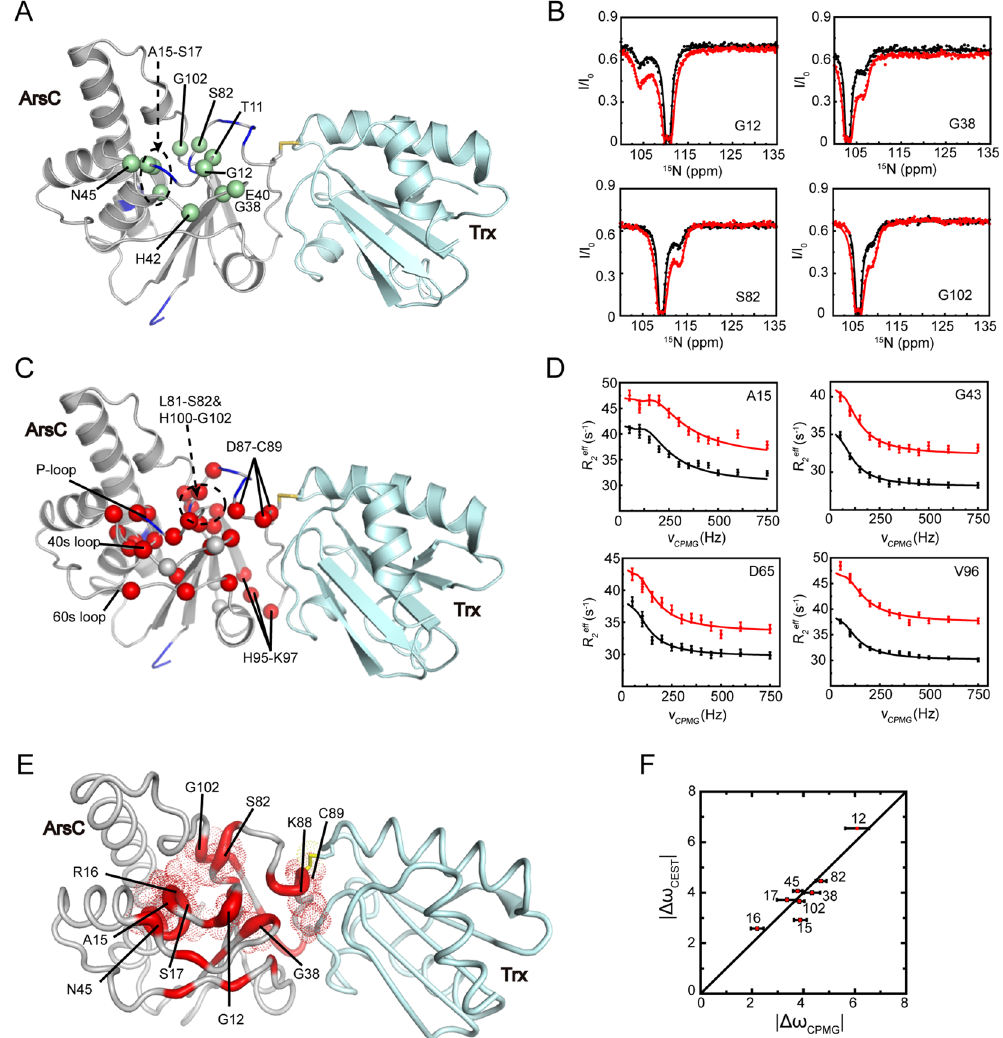
Figure 5. CEST and CPMG RD results of c-ArsC . ( A , C ) Residues showing conformational exchanges in c-ArsC identified by the CEST ( A ) and CPMG RD ( C ) experiments are mapped onto the Trx-ArsC complex structure (PDB ID: 2ipa), shown as green and red spheres, respectively. ( B ) Representative 15 N CEST profiles of c-ArsC obtained on a 600-MHz spectrometer using B 1 fields of 8.4 Hz (black) and 13.5 Hz (red). ( D ) Representative RD profiles of c-ArsC obtained on 600-MHz (black) and 800-MHz (red) spectrometers. ( E ) Mapping of the | Δω | values based on the CPMG RD results onto the c-ArsC structure. Residues undergoing collective motions are colored in red, and the thickness of the cartoon tubes reflects the relative values of | Δω |. Residues with | Δω | > 2.0 are shown as dotted spheres. ( F ) Comparison between the absolute Δω values extracted from CEST and CPMG RD experiments for residues in c-ArsC with residue numbers